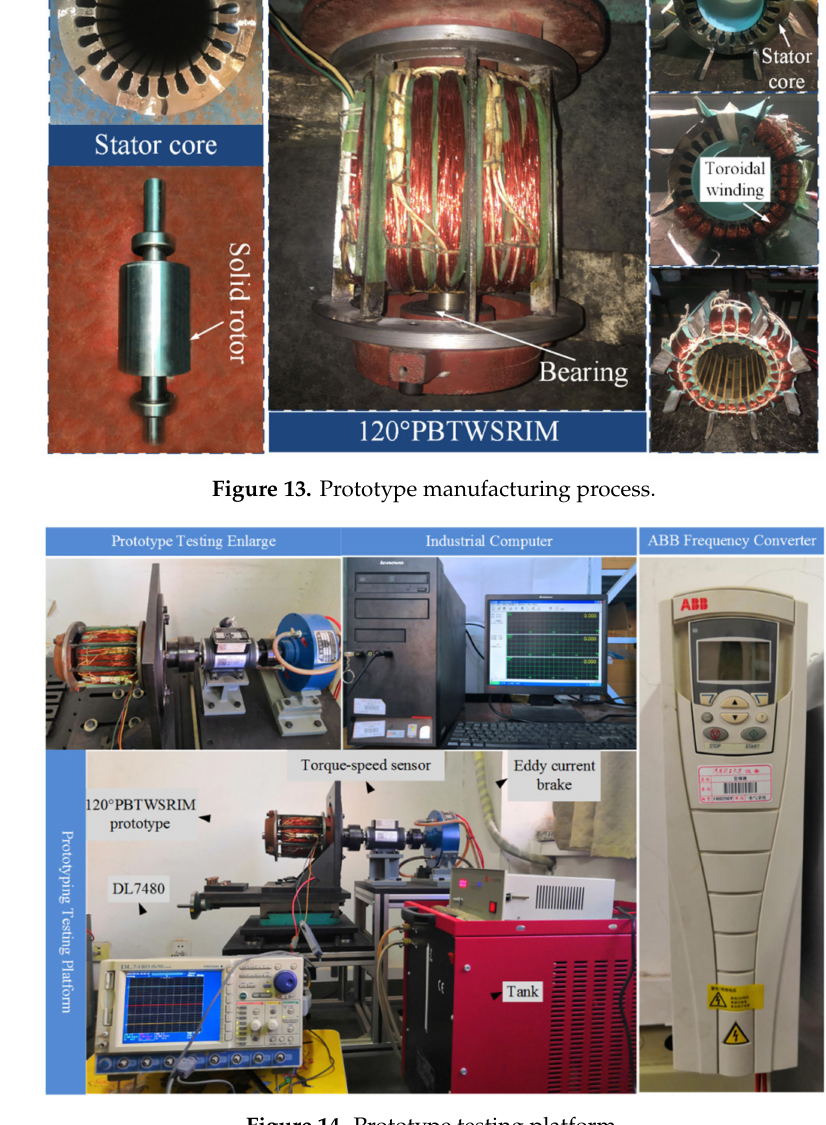
Figure 14. Prototype testing